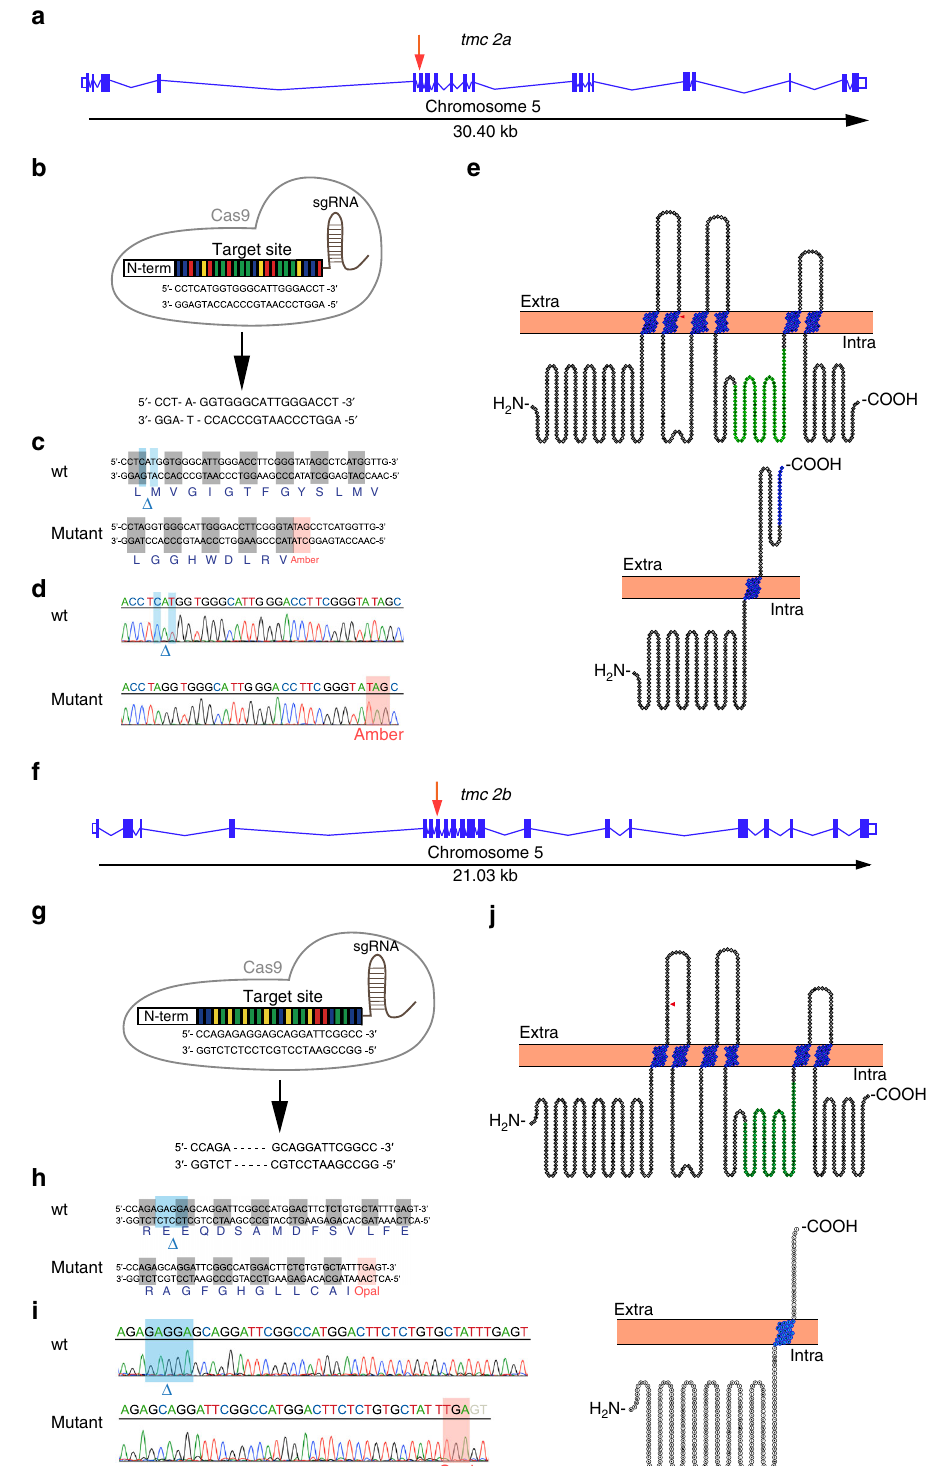
Fig. 7 CRISPR-mediated disruption of tmc2a and tmc2b . Graphical representation of the tmc2a a and tmc2b f loci in zebra fi sh. Putative exons and splice sites are displayed. Red arrows mark the targeted exons. Segments of tmc2a exon 6 ( b ) tmc2b exon 7 ( g ) were subjected to genome editing. Engineered CRISPR sgRNAs bind target sites to enable DNA cleavage. Mutagenesis deleted 2 nucleotides of tmc2a ( b ) and deleted 5 nucleotides of tmc2b ( g ), yielding frame- shift mutations. c , h Amino acid sequences of wild-type and mutant proteins. Sequencing results of mutagenized and control loci, from tmc2a ( d ) and tmc2b ( i ). Blue highlight and blue delta indicate deleted nucleotides in mutants. Red highlight denotes the stop codons that were generated near the CRISPR- targeting site. e , j (top) Topographical representations of the Tmc2a ( e ) and Tmc2b ( j ) proteins. Arrowheads indicate points of introduced mutations. Amino acids of transmembrane domains are labeled in blue and the TMC domains are in green. (bottom) Schematics of predicted truncated polypeptides produced in double mutant are